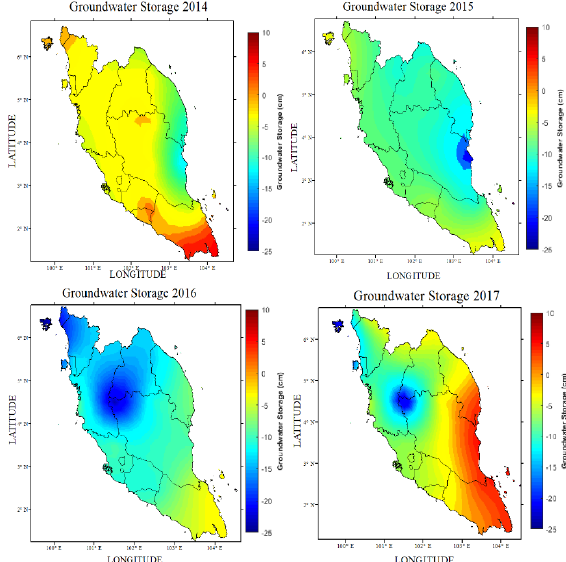
Figure 2. Yearly GWS from 2002 until 2017